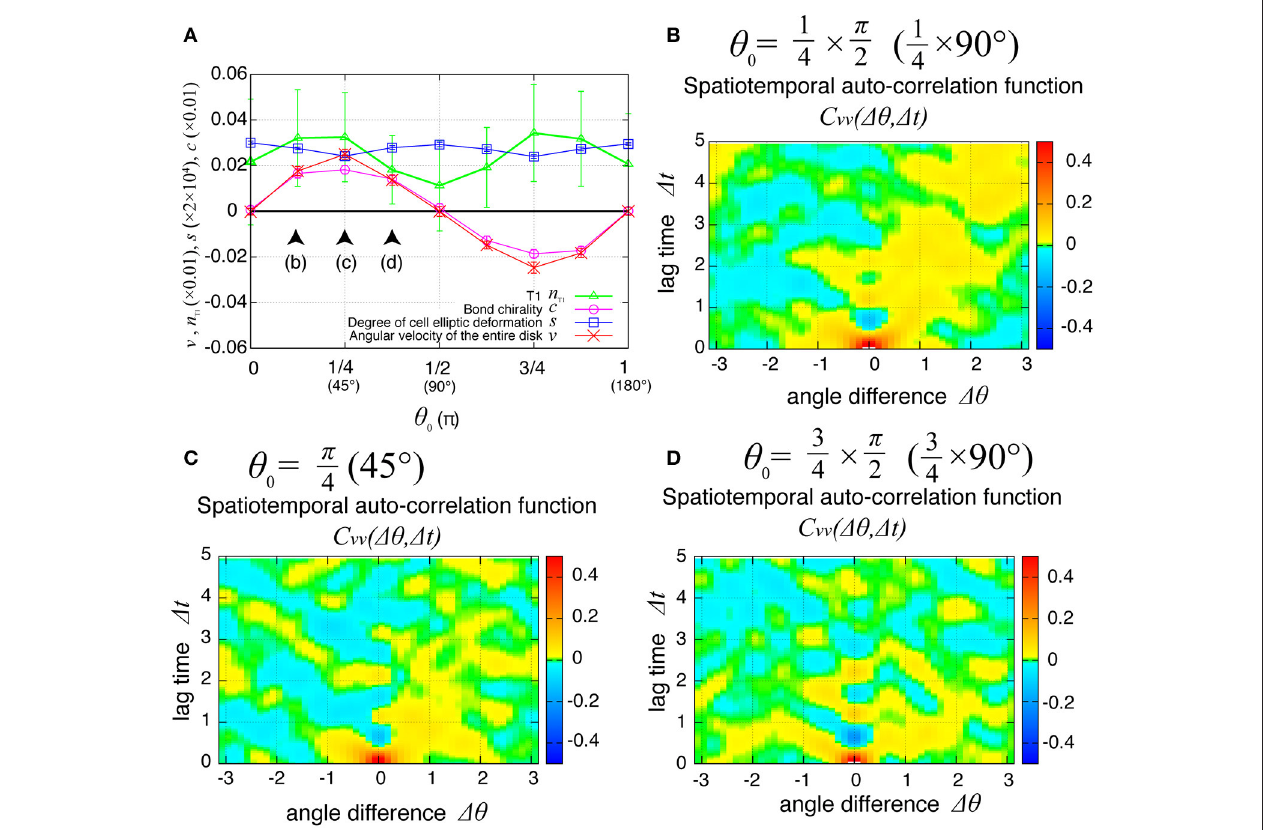
δ v ( θ , t ) δ v ( θ ∆θ , t ∆ t ) /σ 2 v for = h + + i